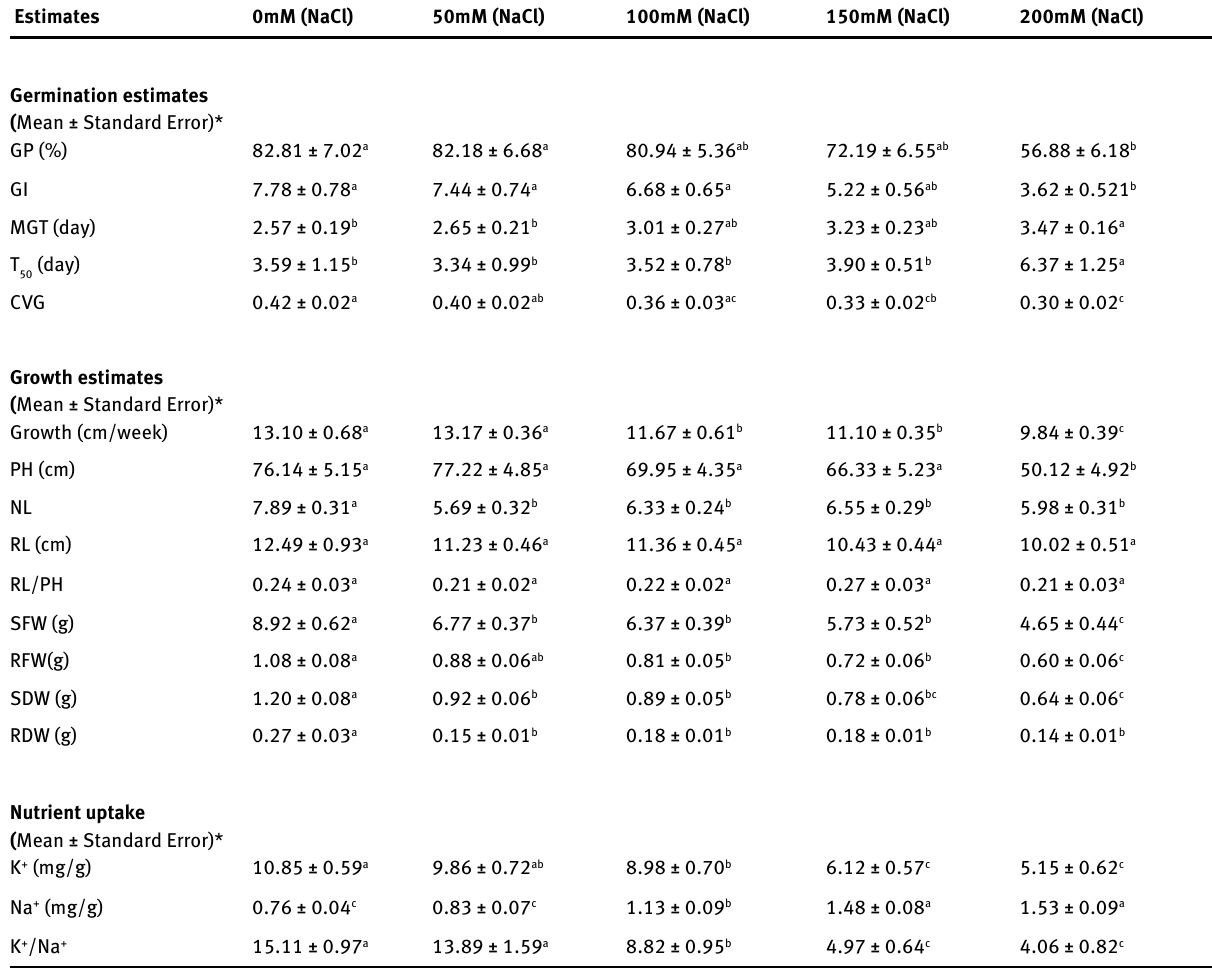
Table 2: Effects of NaCl on germination estimates, growth estimates and nutrient uptake of cultivated Phaseolus vulgaris at 6 weeks*: Each trait mean represents the average of the different observations of the 3 replications of all genotypes. Means followed by the same letter in the same row are not significantly different at p = 0.050 probability level. GP = Germination percentage; GI = Germination index; MGT = Mean germination time; T = Time to 50% germination; CVG = Coefficient of velocity of germination; SFW = Shoot fresh weight; SDW = 50 Shoot dry weight; RFW = Root fresh weight; RDW = Root dry weight; RL = Root length; NL = Number of Leaves; PH = Plant